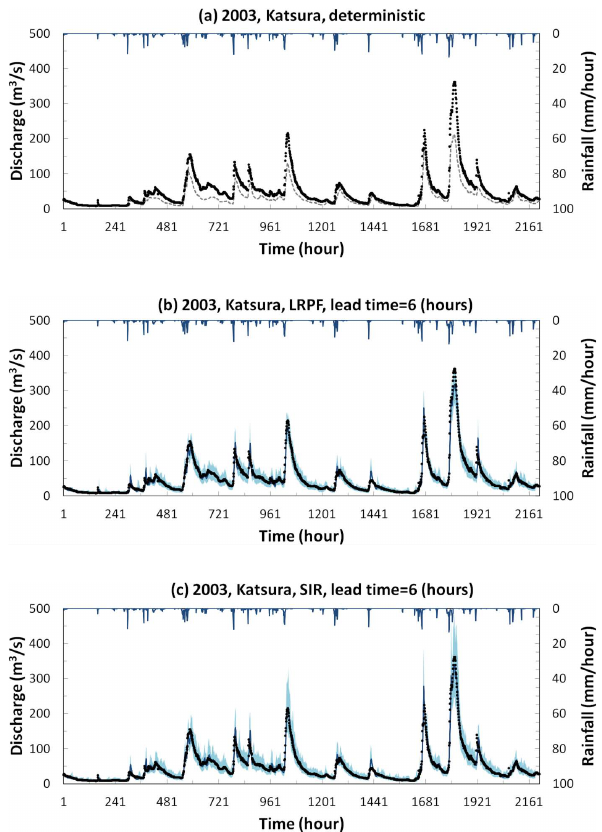
Fig. 9. Observed versus 6-h-lead forecasts at the Katsura station via LRPF and SIR (1 June–31 August 2003): (a) a deterministic modelling case; (b) LRPF; and (c) SIR. The blue line and area rep- resent the mean value and 90% confidential intervals, respectively. A gray dashed line represents a deterministic modelling case. The black dots represent observed